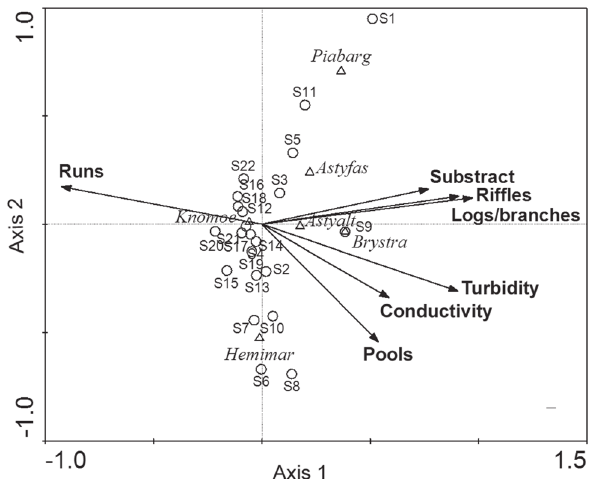
Figure 2. Ordination diagram resulting from canonical correspon- dence analysis, showing 22 sites (open circles), six species (dark triangles) and seven environmental descriptors (arrows). Axis 1 and 2 are significant when tested together (p = 0.008) according Monte Carlo test (499 permutations under reduced model), indi- cating that relationship between species abundance and environ- mental variables is stronger than expected by chance. (Astyalt) A.